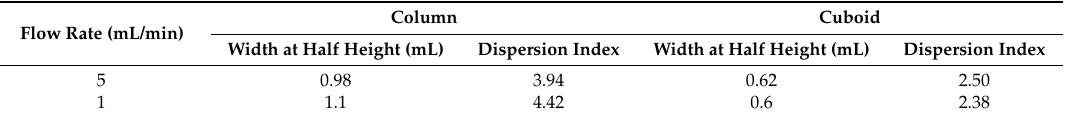
Figure 7. Lysozyme flow-through peaks obtained with the best cuboid packed-bed device and its equivalent column (media: Capto Q anion exchange, bed volume: 5 mL, buffer: 50 mM Tris-HCl, pH 8.0, sample: 1 mg/mL lysozyme, loop: 0.5 mL, flow rate: 1 mL/min, v S = 30 cm/h). Table 2. Comparison of the attributes of the lysozyme flow-through peaks obtained with the best cuboid packed-bed device and its equivalent column (media: Capto Q anion exchange, bed volume: 5 mL, buffer: 50 mM Tris-HCl, pH 8.0, sample: 1 mg/mL lysozyme, v S = 30 and 150 cm/h for the flow rate of 1 and 5 mL/min respectively, injection volume: 0.5 mL)